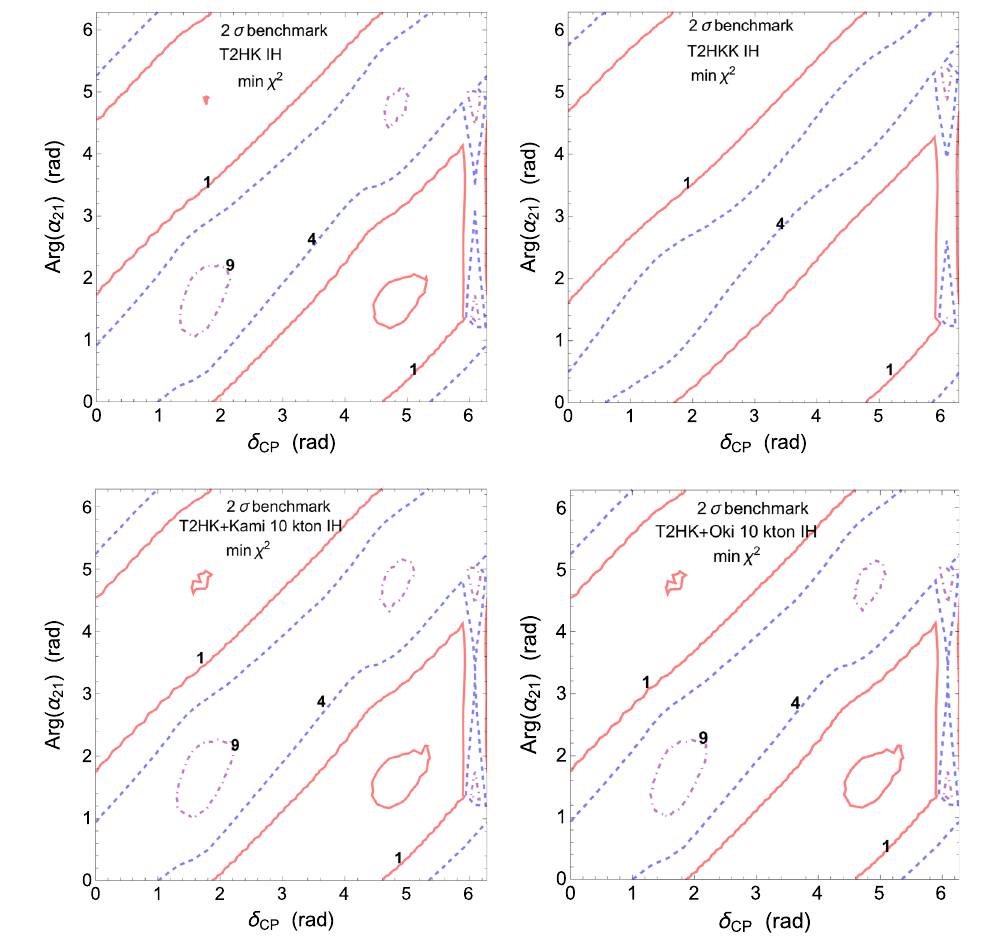
Fig. 14 The minimum of χ 2 ((cid:20)) Eq. (32), min χ 2 . The benchmark with Eq. (37) is assumed, and the true mass hierarchy is inverted. The upper-left, upper-right and lower-right subplots correspond to the T2HK, the T2HKK, and the plan of the T2HK plus a 10 kton water